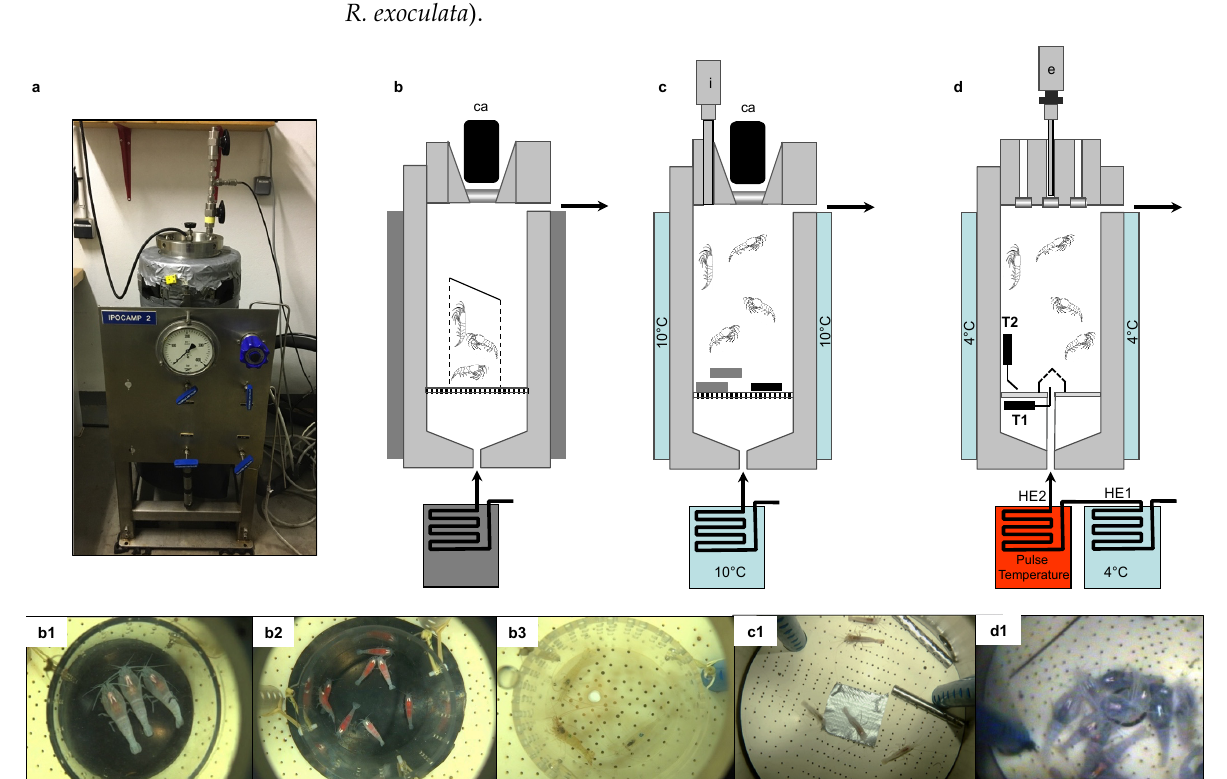
Figure 4. Setups for experiments in the pressure vessel IPOCAMP. ( a ) The pressure vessel IPOCAMP (internal diameter 20 cm, height 60 cm [36]); ( b ) experimental setup for grooming observations. Arrows indicate the inlet and outlet of circulating seawater. This device also used for chemical stimuli experiments, see ( c ), is a recently upgraded version of the lid of the vessel IPOCAMP. The new lid comprises a large viewport and consequently allows direct observation as well as video recording with a high definition camera (ca, AG-HCK10G HD camera head, AG-HMR10 portable recorder, Panasonic). Three shrimp were placed in a PVC cage closed at the top with a transparent polyethylene lid. The behavior of the shrimp was recorded throughout the experiment. Pictures ( b1 – b3 ) are views of the following animals in the IPOCAMP aquarium during grooming observations: ( b1 ) R. exoculata females and male (marked with a black line); ( b2 ) R. exoculata juveniles; ( b3 ) Palaemon serratus juveniles. Body length of the observed shrimp is about 4–5 cm for R. exoculata and P. serratus juveniles, and about 2 cm for R. exoculata juveniles. ( c ) Experimental setup for chemical stimuli experiments. Arrows indicate the inlet and outlet of circulating seawater. The seawater inlet pipe passes through a thermostatically controlled bath. The lid is equipped with an isobaric line (i) that allows the introduction of small elements (e.g., food, stimulus) without disrupting the pressure inside the aquarium. During the experiment, two control gels (grey bars) and one stimulus gel (black bar) were introduced into the tank through the isobaric line at 45 -min intervals. Picture ( c1 ) shows Mirocaris fortunata in the IPOCAMP aquarium during this experiment. Specimens lie on the plastic bottom of the tank with holes for water entrance, two stainless steel tubes that contain gels are visible. ( d ) Experimental setup for temperature and sulfide pulse experiments. Three sapphire viewports in the pressure vessel lid allow the insertion of an endoscope (e) (Fort, Dourdan, France) and two optical -fiber light -guides for the behavioral observation. The experiments are recorded by a CCD camera (JVC, TK-C1380) and a DVD recorder (DVO-1000MD, Sony). A diffuser system, consisting of a plastic cap with holes, is placed over the seawater